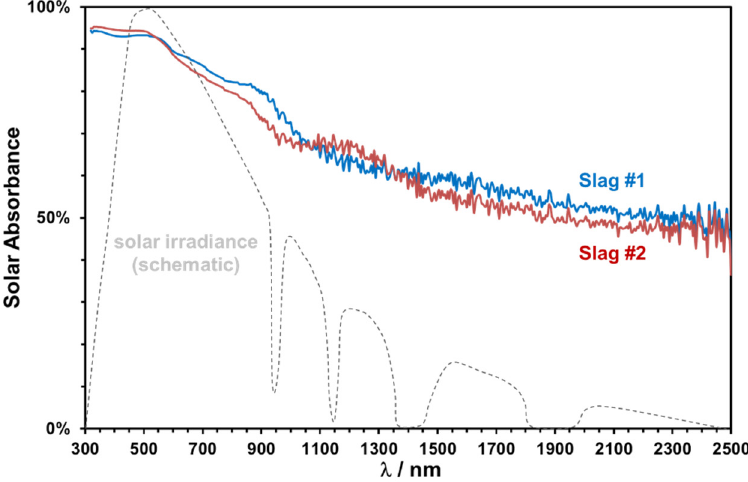
Figure 16. Solar absorptance of the slags sintered at 1000 °C and normalized solar irradiance (dashed line).